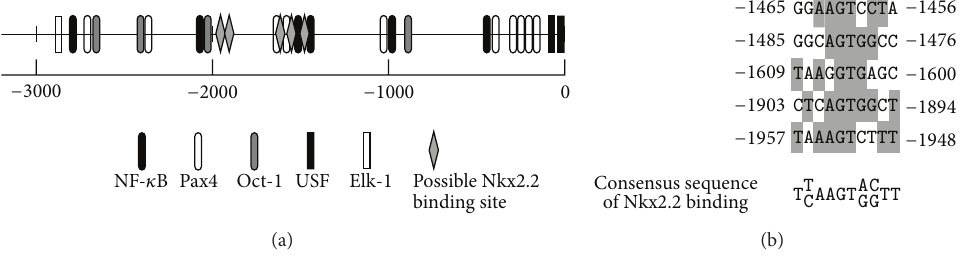
Figure 4: Localization of several transcription factors in the human ghrelin promoter sequence. (a) Possible binding sites of NF- 𝜅 B, Pax4, Oct-1, USF, Elk-1, and Nkx2.2. (b) Possible Nkx2.2 binding sequences. Nucleic acids that match the consensus Nkx2.2 binding sequence are